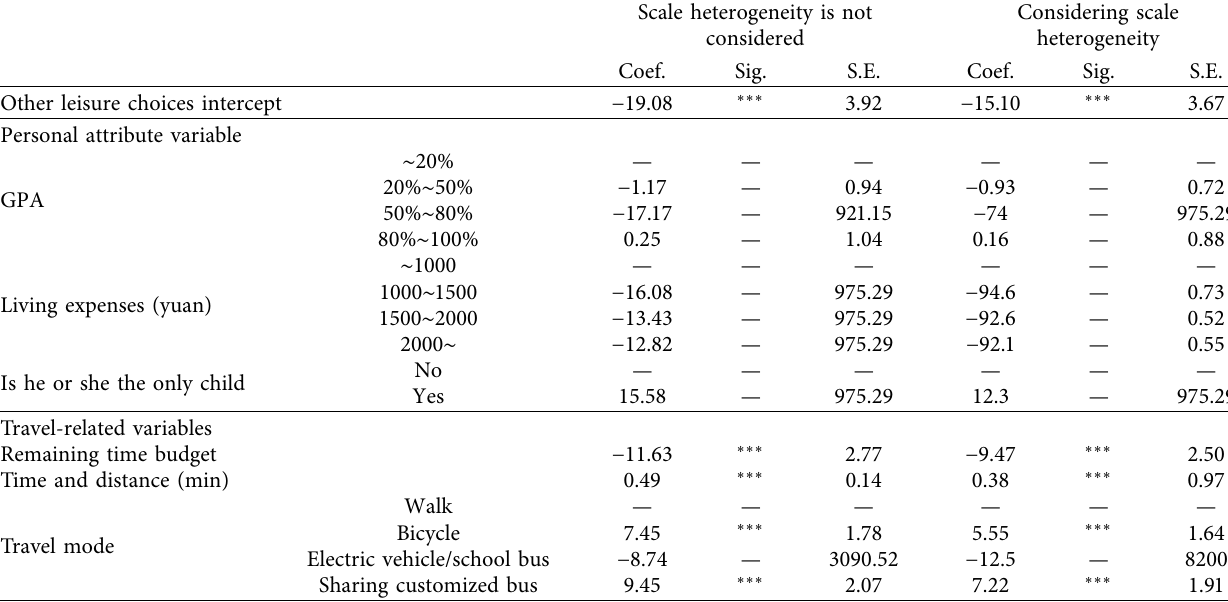
Table 5: Analysis of influencing factors based on activity travel behavior analysis